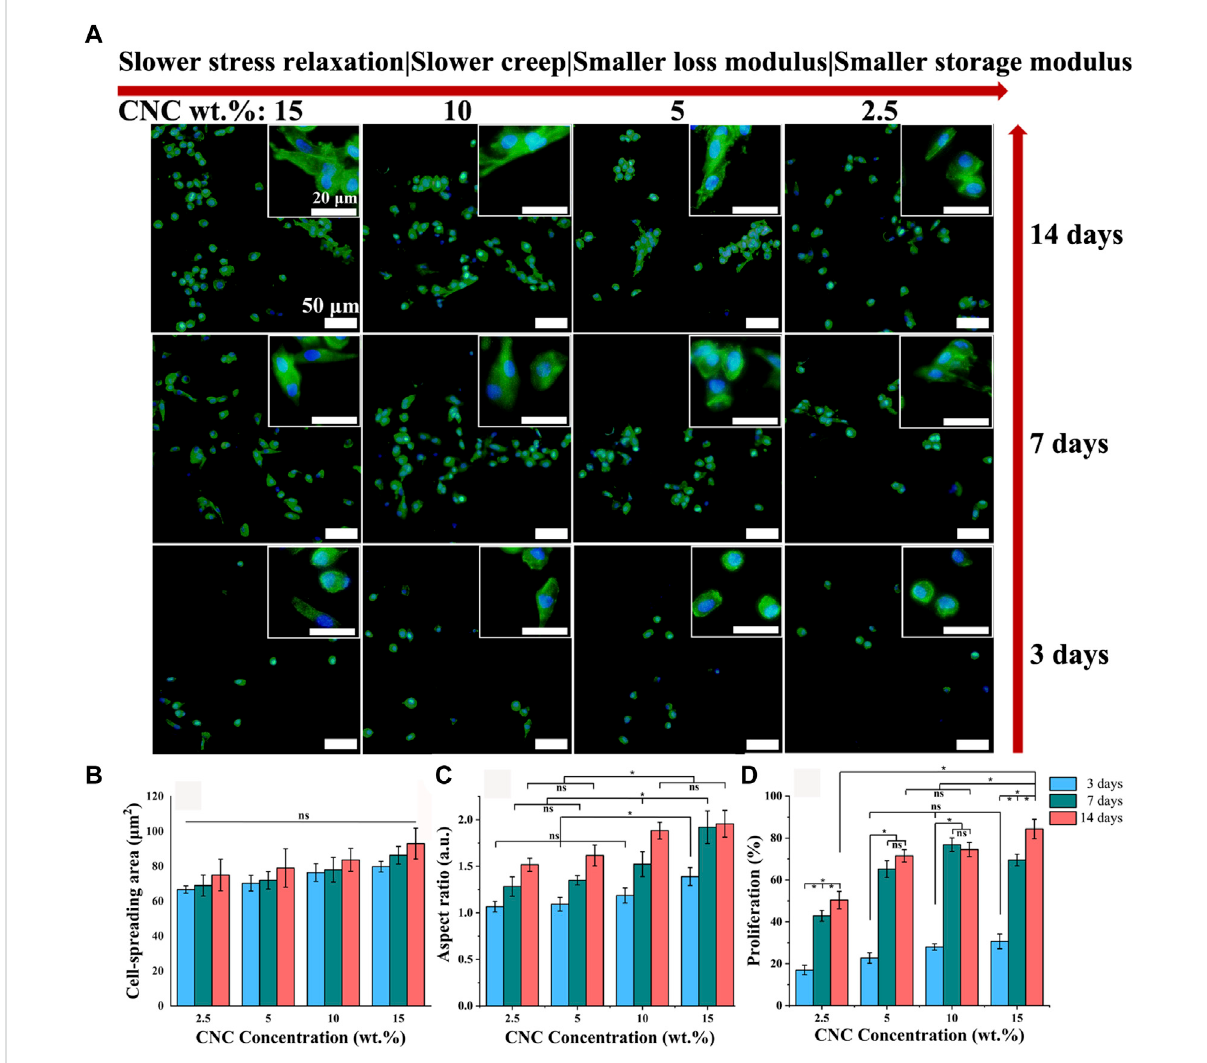
FIGURE 5 Cell spreading and proliferation for chondrocytes cultured in hydrogels with different viscoelastic properties. (A) Images of chondrocytes cultured in hydrogels with the indicated CNC concentration (2.5 wt.%, 5 wt.%, 10 wt.%, and 15 wt.%). Green represents actin staining and blue represents nucleus. Images were taken after 3, 7, and 14 days in culture. Scale bar is 50 μ m. (B – D) , Spreading area, aspect ratio, and proliferation of chondrocytes (* p <